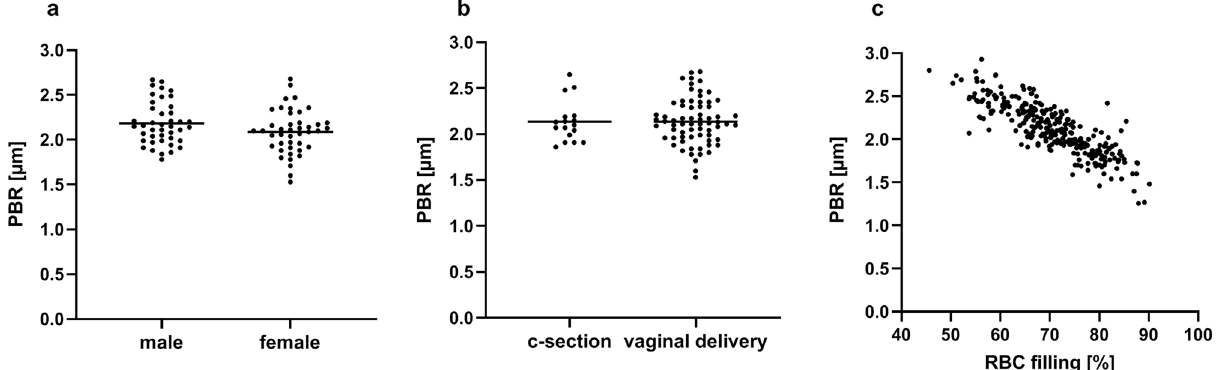
Figure 2. PBR values in mature neonates at 36–72 h of life. ( a ) Gender and ( b ) birth mode did not have a significant influence of PBR values. ( c ) A significant inverse correlation of PBR values and RBC filling was observed (r = − 0.87, p < 0.0001).